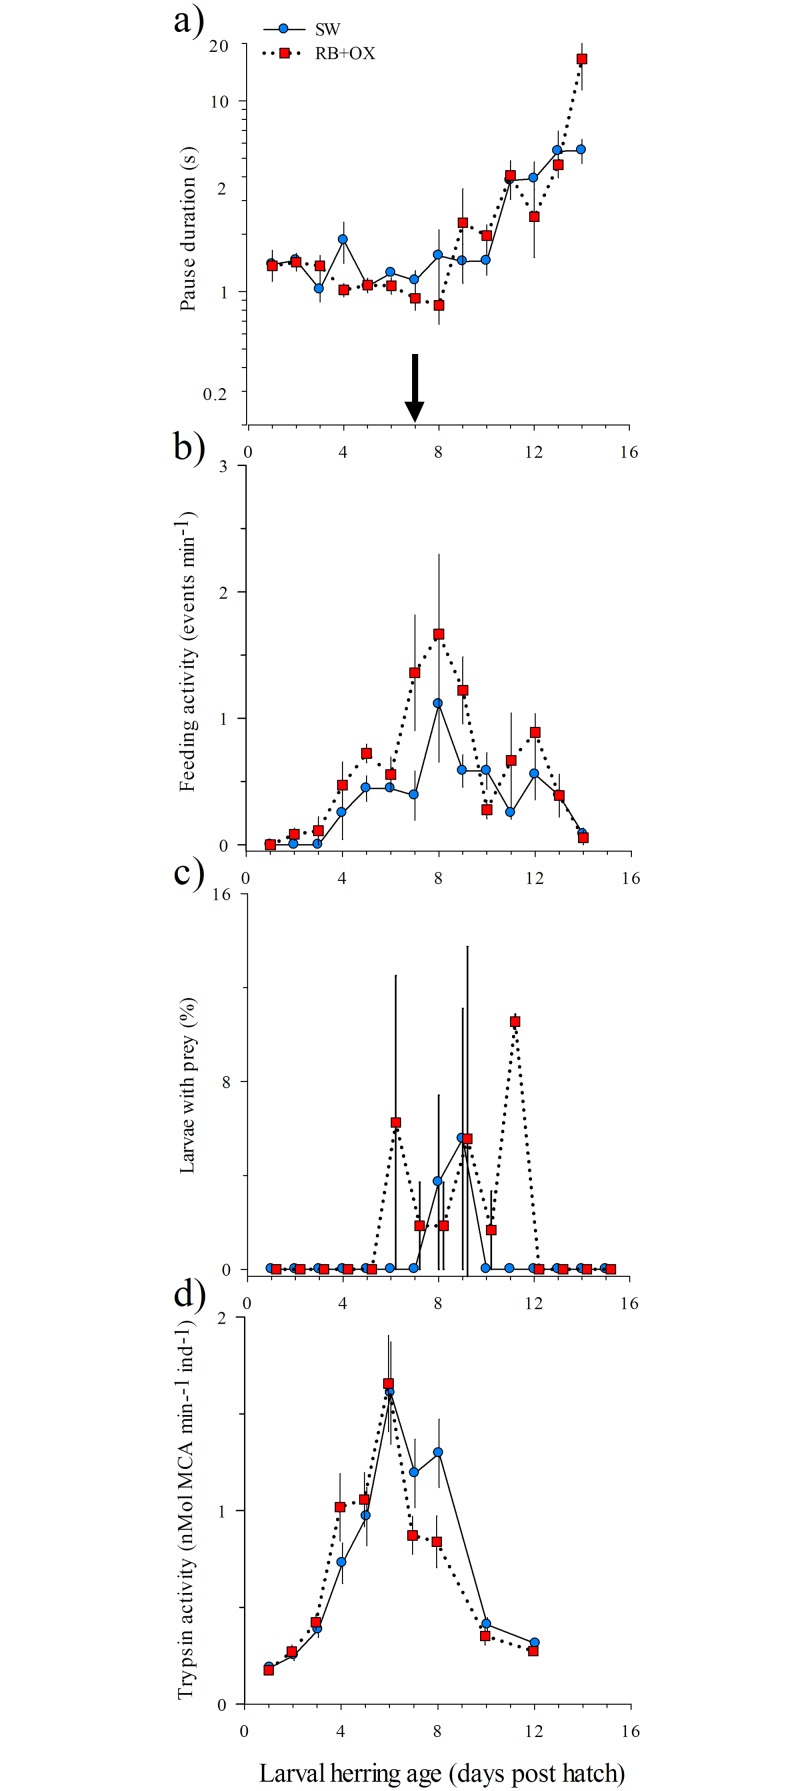
Mean (±S.E., n = 3 tanks) swimming activity (a), feeding activity (b), number of prey within the gut (c) and trypsin activity (d) versus age (days post hatch, dph) for yolk sac larval herring (Clupea harengus) reared in the absence and presence of Rhodomonas baltica (RB) + Oxyrrhis marina (OX).The black arrow indicates the age of complete yolk absorption. Significant differences between treatments were observed in feeding activity (panel b, P = 0.01, one-way repeated measures ANOVA on ranks).